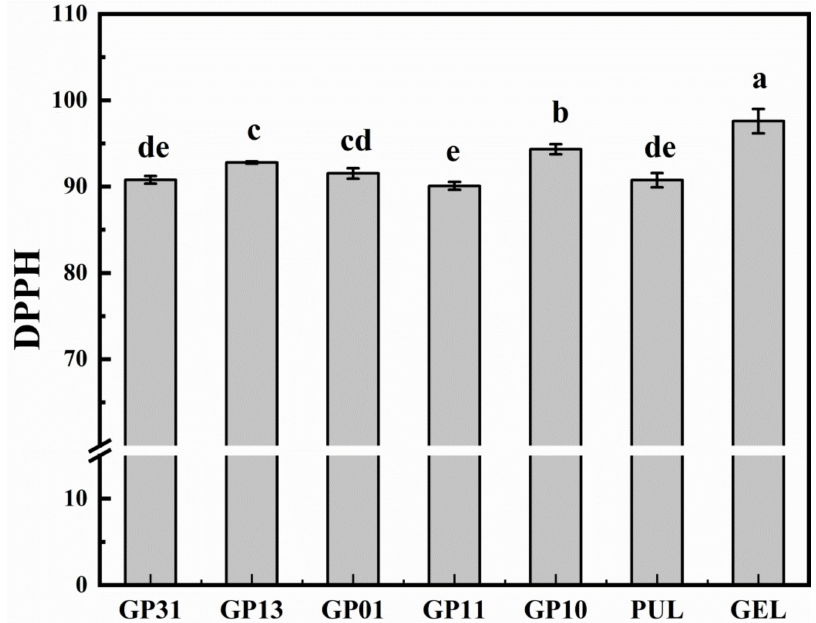
Figure 7. 2,2-Diphenyl-1-picrylhydrazyl (DPPH) radical scavenging activity of different